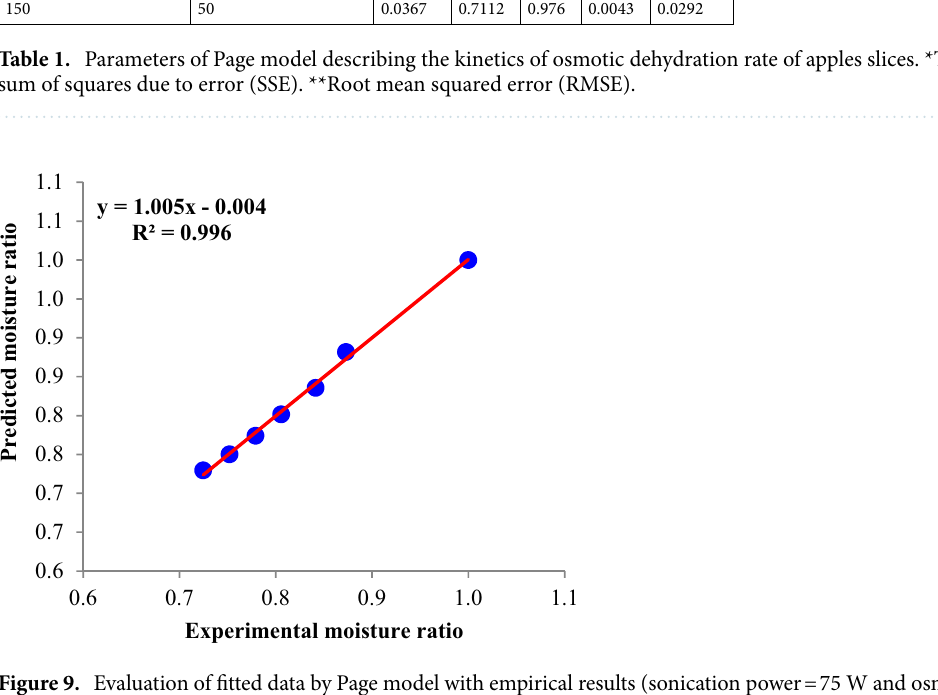
Figure 9. Evaluation of fitted data by Page model with empirical results (sonication power = 75 W and osmotic solution concentration = 40°